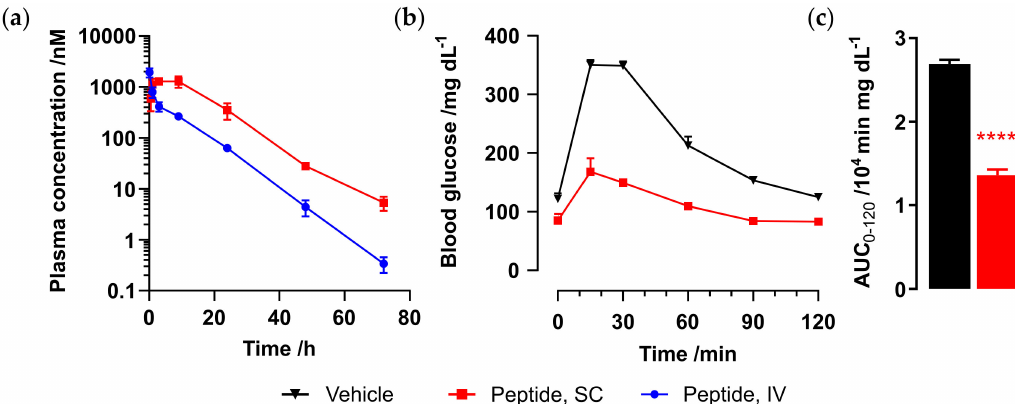
Figure 7. ( a ) Mouse pharmacokinetic data for Ex-4[M14L, E17C, E24C]- S2 administered via intravenous (IV) or subcutaneous (SC) injection to male CD-1 mice (n = 3), blood samples were collected between 0.5 and 48 h after dosing, and plasma concentration of the peptides was analyzed via CRE luc reporter functional assay, as detailed in the Materials and Methods section; ( b ) oral glucose tolerance test (OGTT) 1 h after administration of vehicle (phosphate-bu ff ered saline, PBS, pH 8.2, black line) or Ex-4[M14L, E17C, E24C]- S2 (0.05 mg / kg, SC); **** p < 0.0001, relative to vehicle control; ( c ) refers to plasma glucose levels obtained by measuring the area under the curve (AUC). Table 4. Mouse pharmacokinetic data for Ex-4[M14L, E17C, E24C]- S2 .